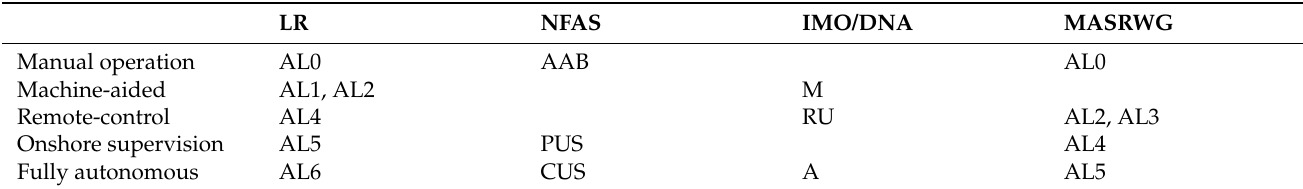
Table 3. Correspondence table for ship autonomy